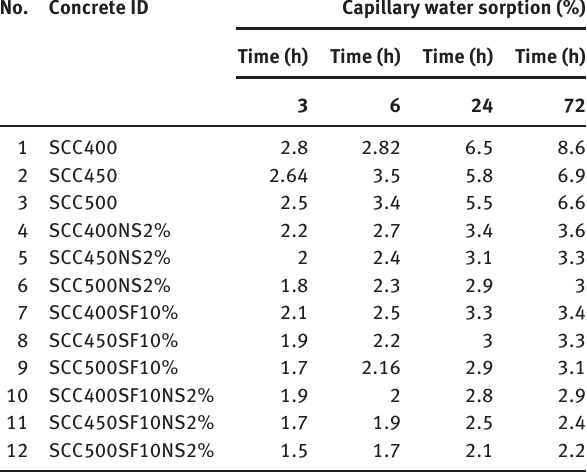
Table 6 Results of capillary absorption by